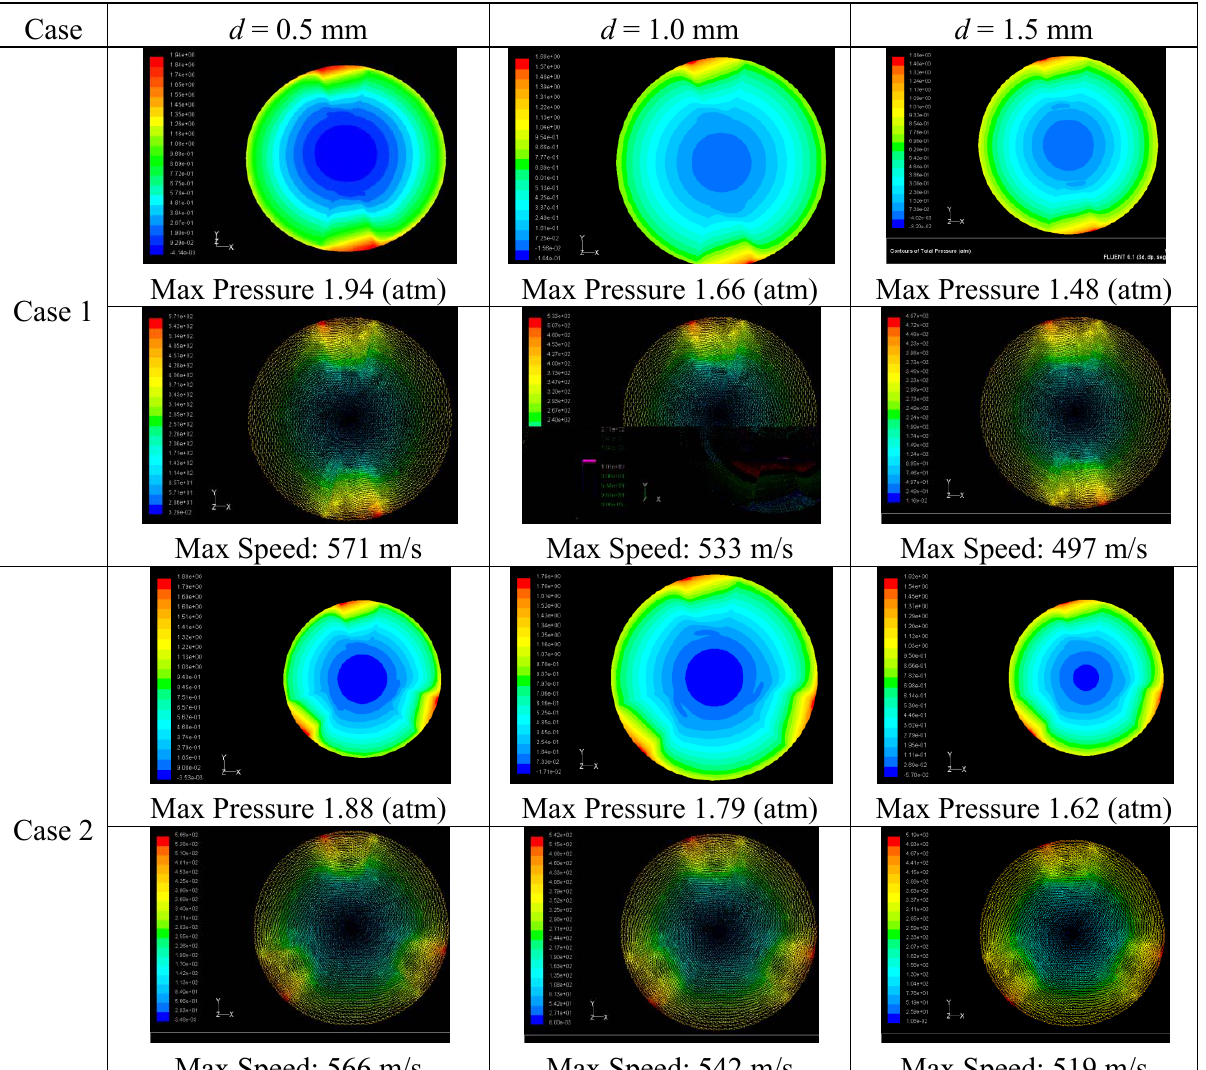
Table 4. Contour plots of Pressure and Velocity Generated by Passive Squeezing